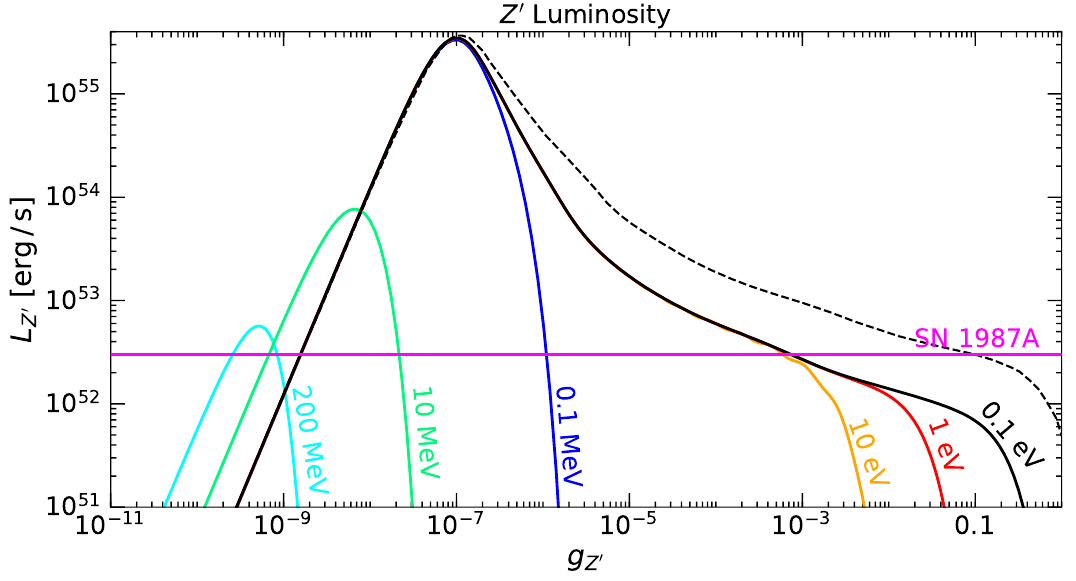
Figure 2. Luminosity due to Z 0 production in the PNS as a function of the coupling g 0 gauged L µ − L τ model, and the SFHo18.8 profile. The “SN1987A” line gives the value L ν defined in eq. (3.5). The different color lines show different masses m Z 0 as labeled. The dashed line shows the impact of changing R far → R ν in eqs. (3.3) and (3.4) for m Z 0 = 0 . 1 eV .